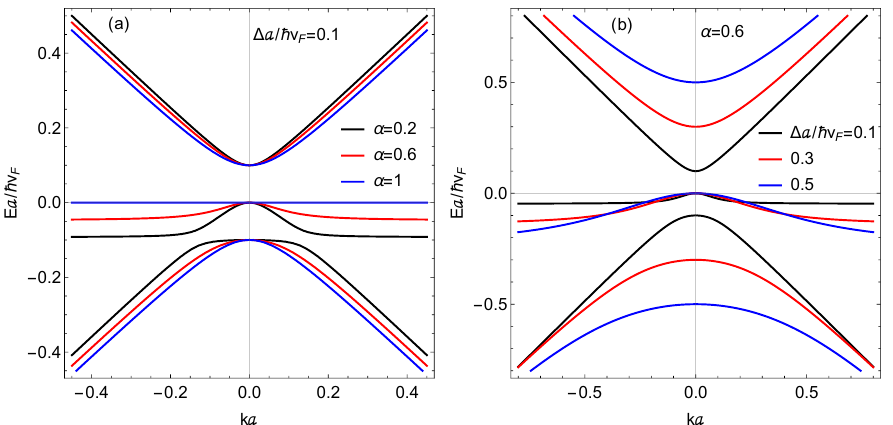
Figure 1. Energy dispersion (in units of ¯ hv F / a , where a is the lattice parameter) as a function of wave number (in units of 1/ a ) ) of the subbands determined by solving Equation (3) with the mass term having ( a ) ∆ a /¯ hv F = 0.1 and the hopping parameter α is 0.2, 0.6 and 1.0. In ( b ), we chose α = 0.6 and calculated the subband spectra for various values of ∆ in units of ¯ hv F / a